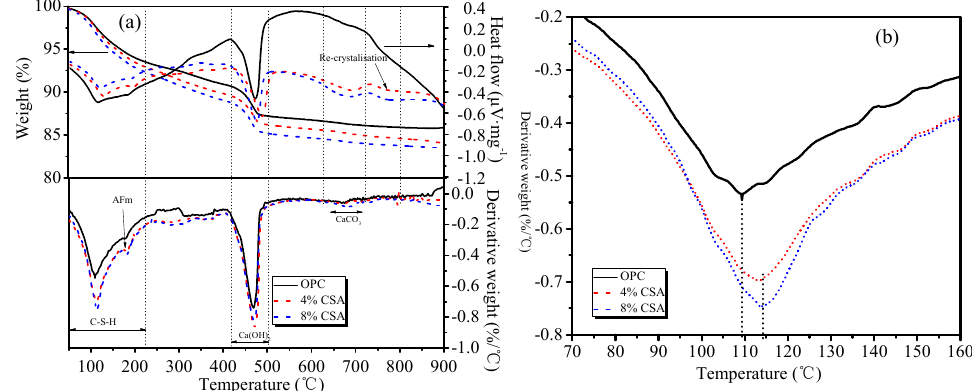
Figure 6. Thermogravimetric analysis of hydration products at 28 days: ( a ) TG-DSC curves and ( b ) the mass loss of C-(A)-S-H.